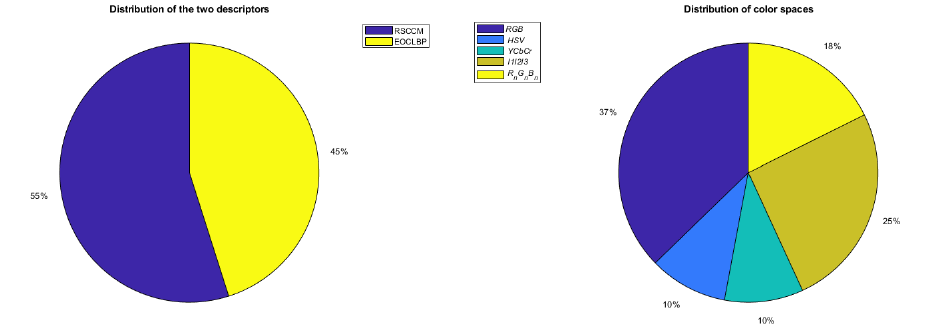
Figure 12. Distribution of the two descriptors and the five color spaces with the CHMCS representa- tion for the USPtex